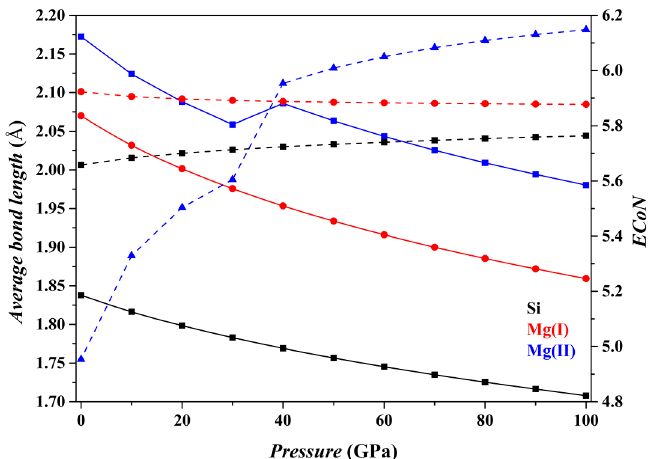
Figure 4. Evolution of the average bond length ( d mean ) and ECoN parameters of the polyhedra of the Fo-III phase as pressure increases from 0 to 100 GPa (0 K). For the information about the Mg(I) and Mg(II), see Supplementary Tables S4 and S5.